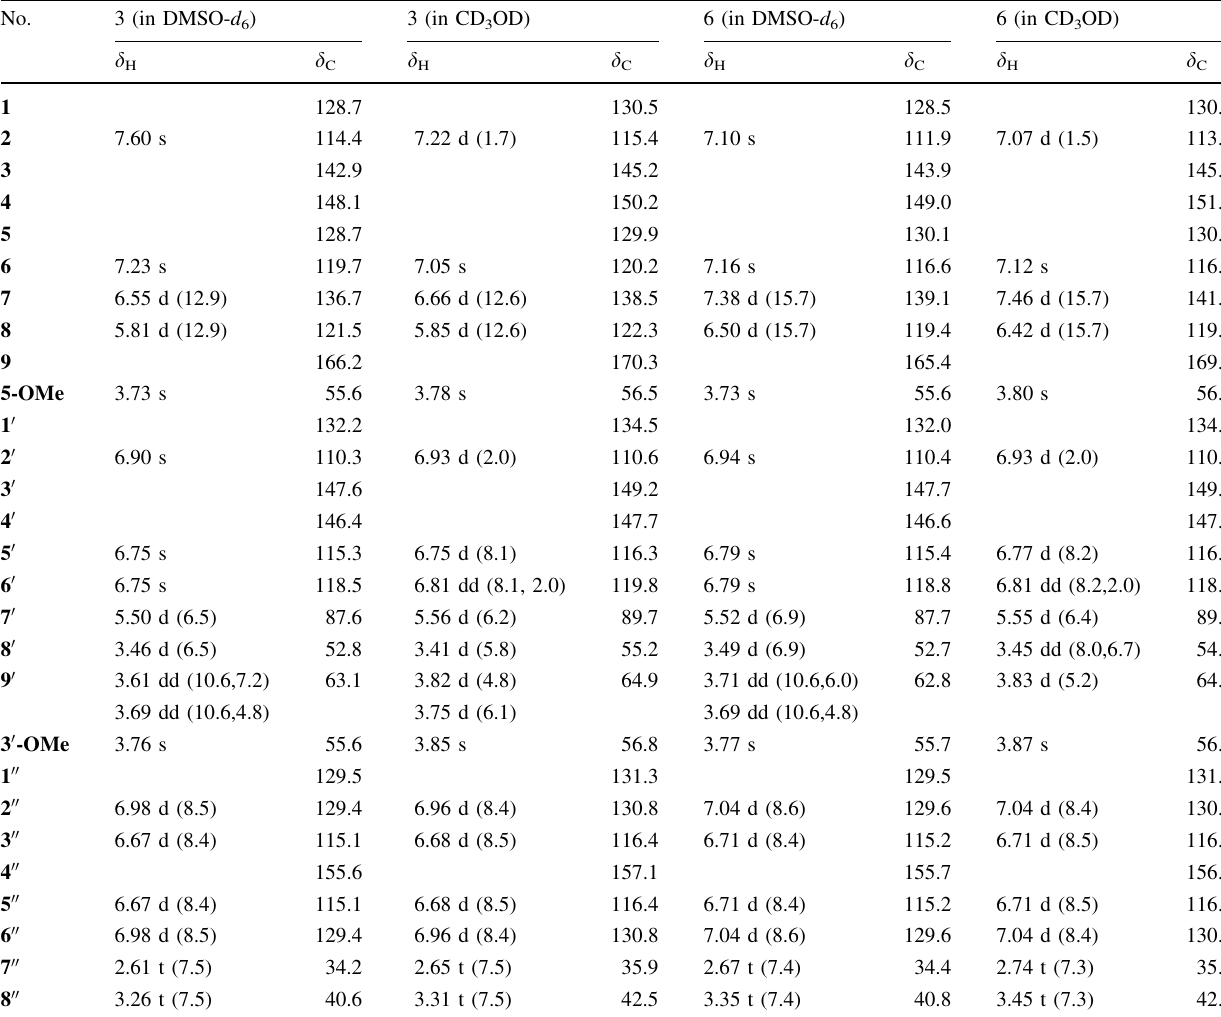
Table 2 1 H (500 MHz) and 13 C NMR (125 MHz) Data for compounds 3 and 6 in DMSO- d 6 and CD 3 OD ( d in ppm, J in Hz)